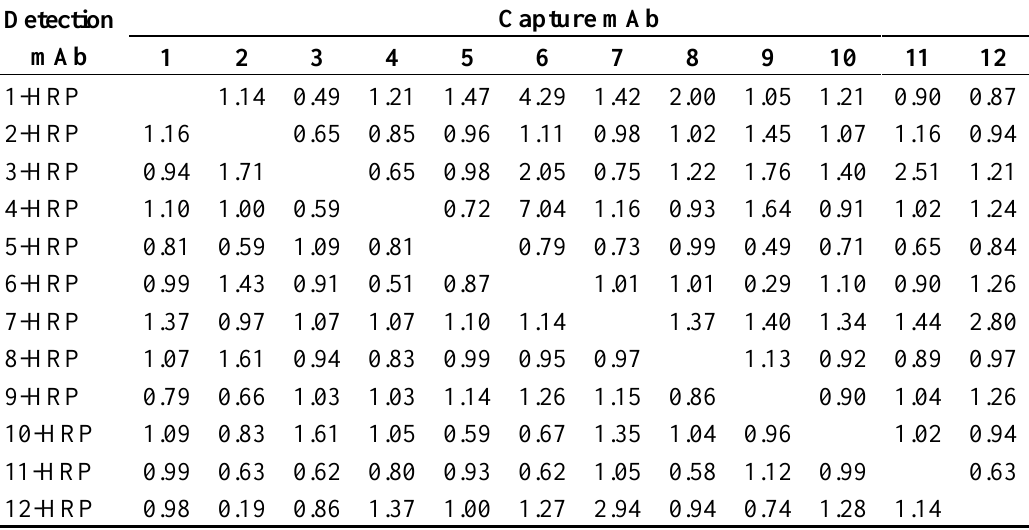
Table 1. Sandwich ELISA for pairwise interaction analysis (P/N value).